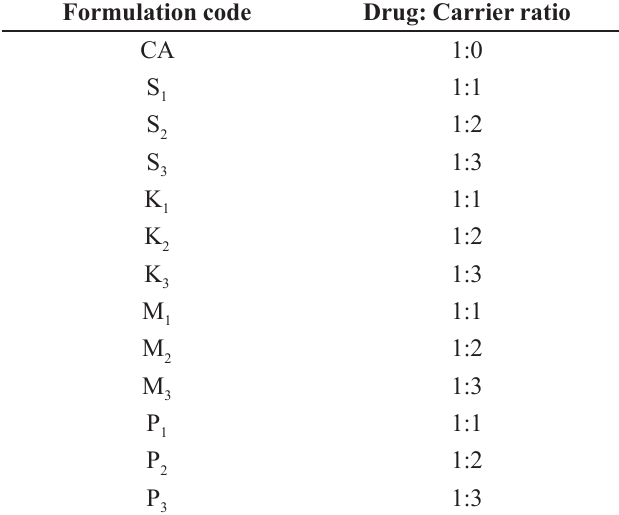
(Table I) were used for preparing CA solid dispersions (MEM), solvent method (SM) and kneading method